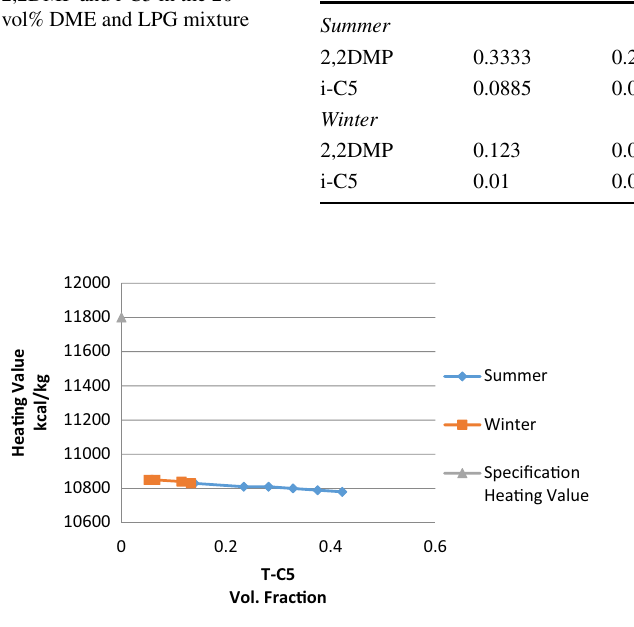
Table 9 Volume fraction of 2,2DMP and i-C5 in the 20 vol% DME and LPG mixture